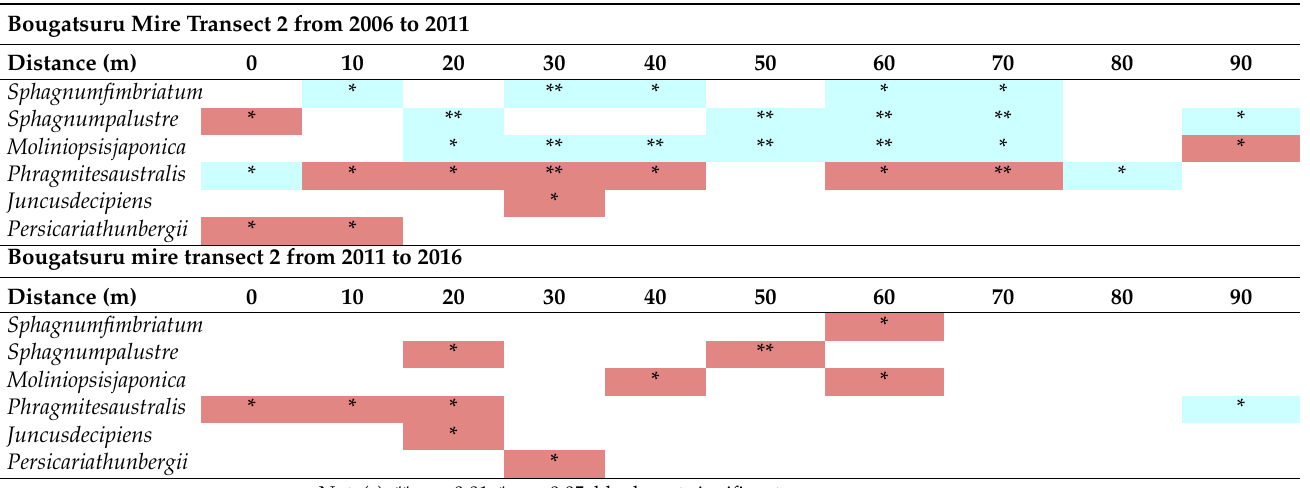
Table 3. Significance levels of difference of coverage of abundant species between 2006 and 2011 and between 2011 and 2016 at water environment monitoring sites along the Bougatsuru transect 2 (Bougatsuru transect 2). Five 1 × 1 m 2 quadrats of both sides of each water environment monitoring site (one side at both end sites) were assigned to each site. Significance of difference was tested by Wilcoxon test. Red colored cells show the increase in coverage and blue colored cells show decrease in coverage from the beginning to the end of each